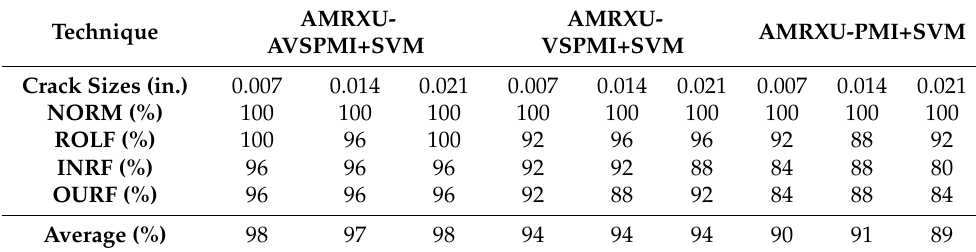
Table 8. The accuracy of state identification (torque load: 3